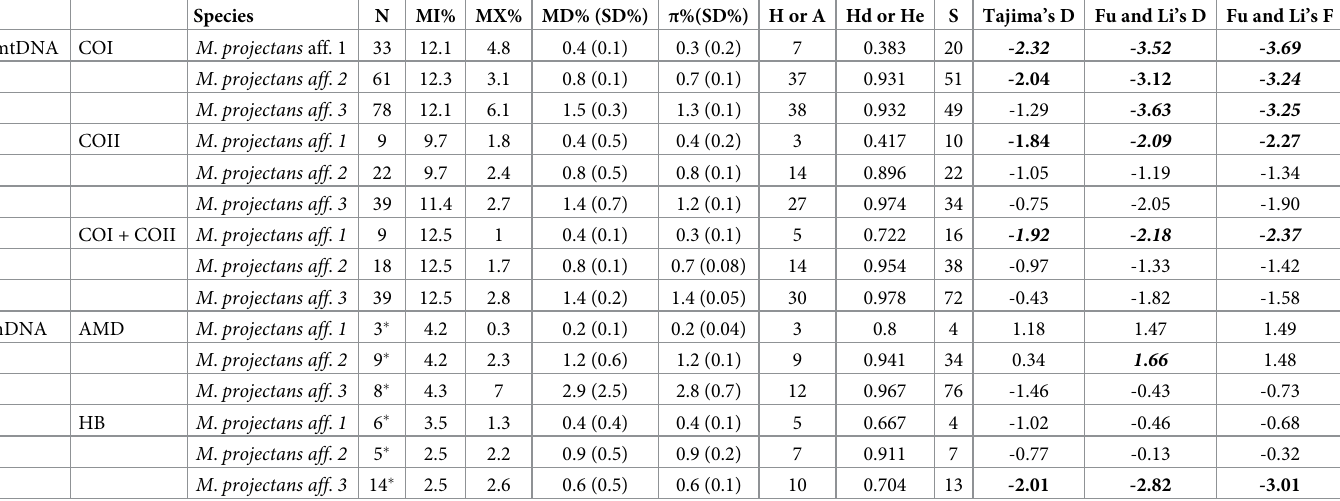
Table 1. Summary information regarding sample size (N), divergence (MI%, MX% and MD%) and diversity analyses ( π %, H or A, Hd or He and S) and results of neutrality tests (Tajima’s D, Fu and Li’s D and Fu and Li’s F) performed for each of the three species of the M . projectans complex with each of the employed mito- chondrial and nuclear